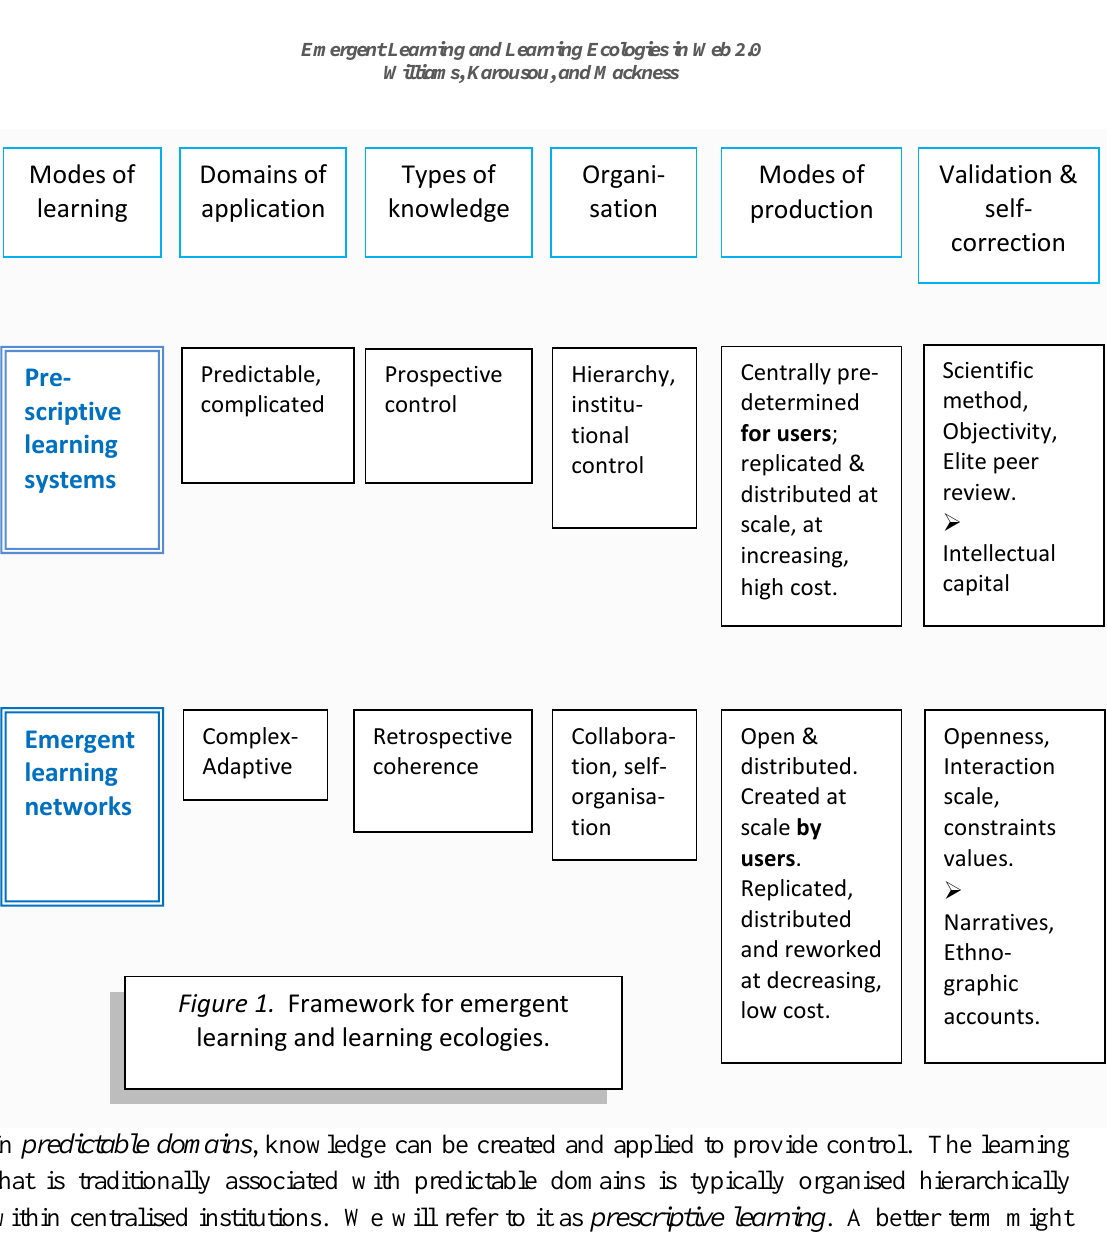
Figure 1. Framework for